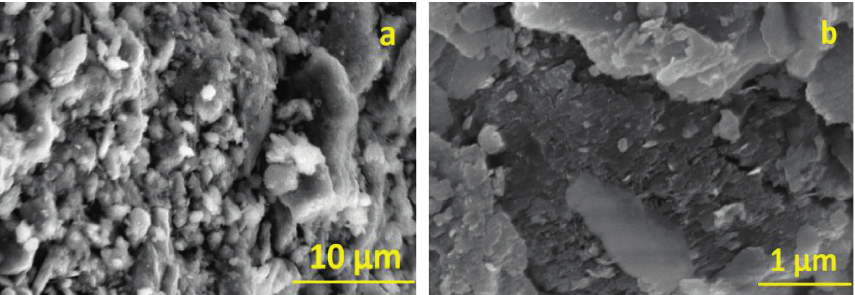
Figure 10: SEM image of purified clay ANp before (a) and after (b) MR-dye